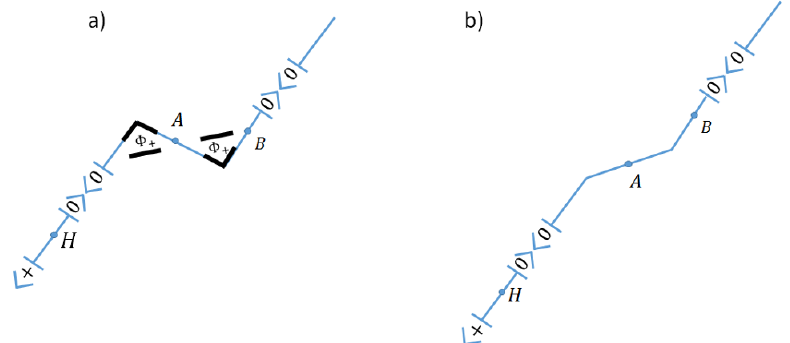
Figure 4 . Measurement testing independence of clones viewed in two di(cid:11)erent reference frames (as in (cid:12)gure 1 H , A , B are seen by one observer as three systems, while by another observer as one system appearing at di(cid:11)erent instance of